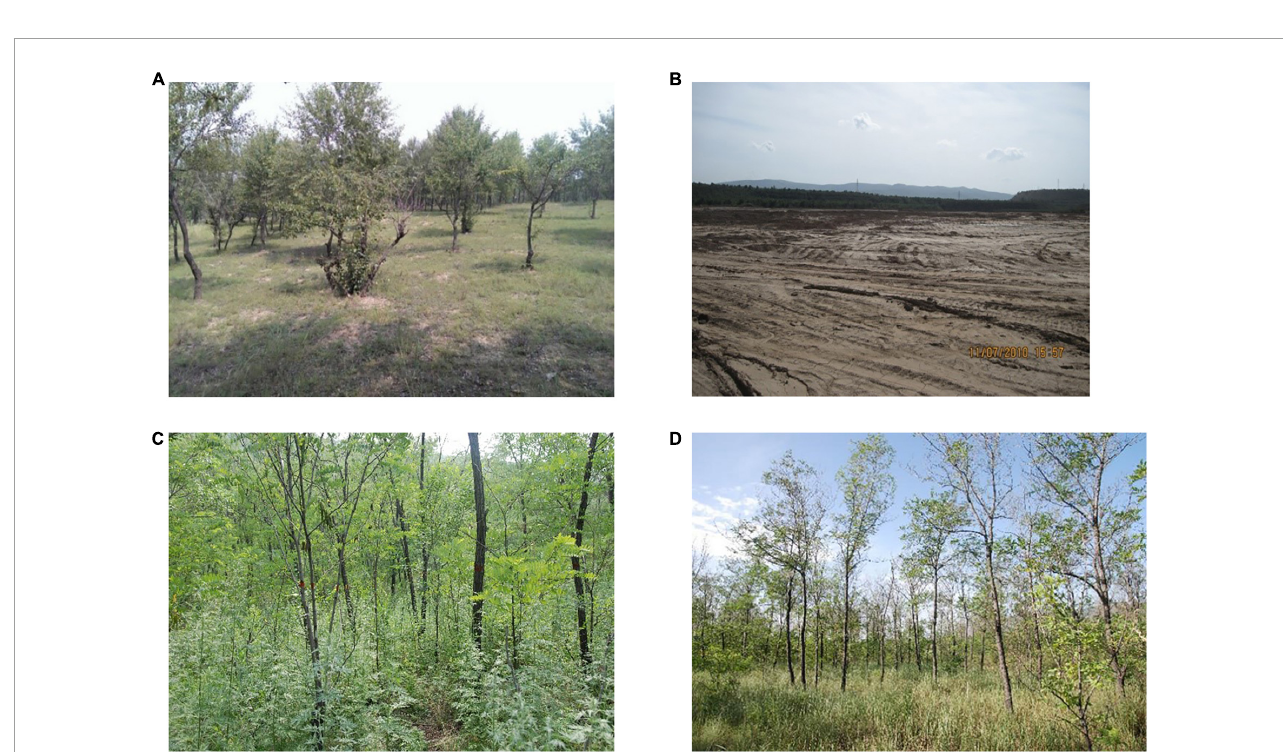
FIGURE2 Vegetation types before and after restoration. (A) Original vegetation; (B) damaged vegetation; (C) mingled stand; (D) pure